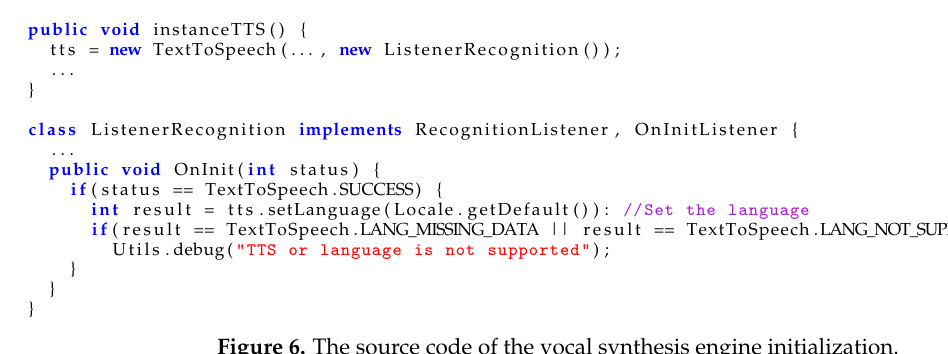
Figure 6. The source code of the vocal synthesis engine